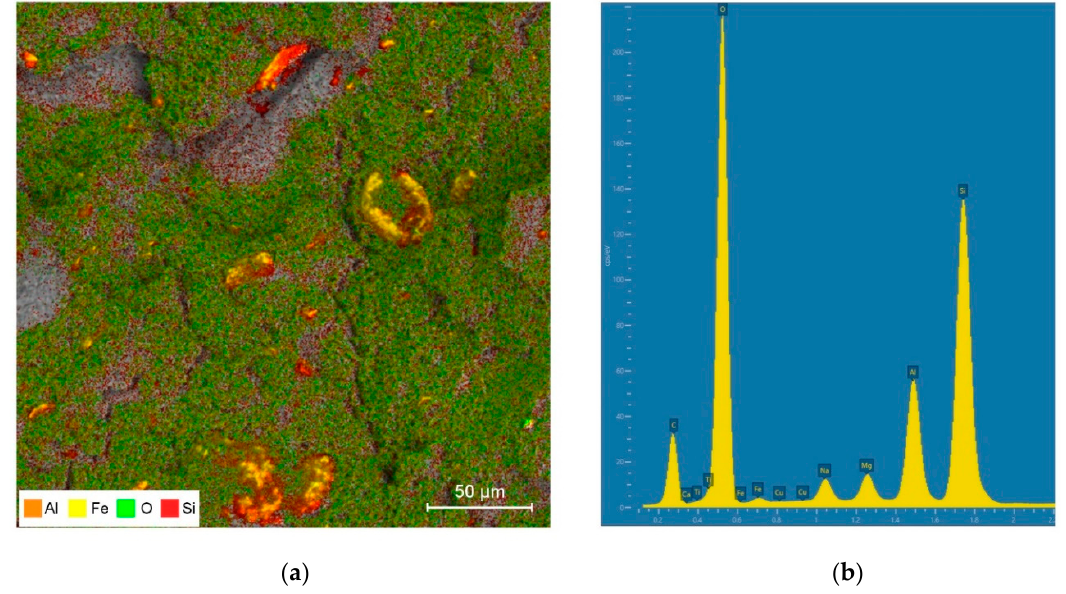
Figure 3. ( a ) Energy dispersive spectroscopy (EDS) mapping, and ( b ) the distribution of chemical composition of bentonite.